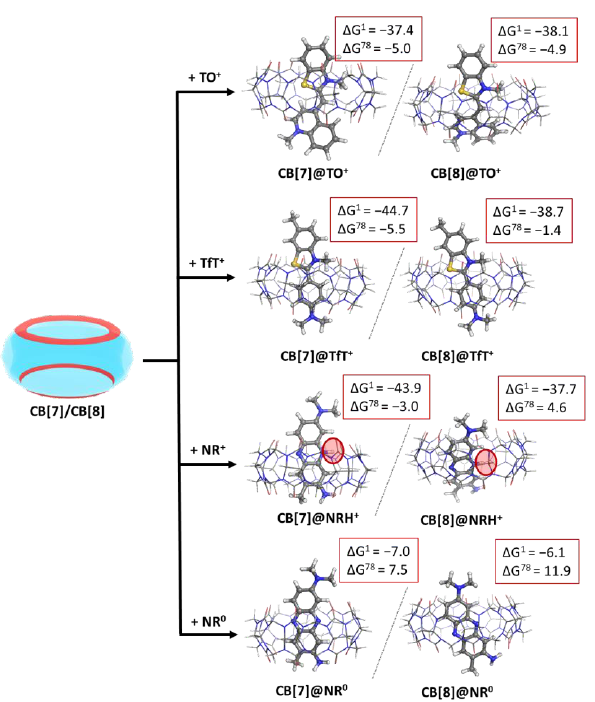
Figure 2. M062X/6 −3 1G(d,p) optimized structures of the CB[7/8]@dye complexes in the gas phase and the corresponding ∆G ε values in kcal mol −1 for their formation in the gas phase ( ε = 1), and water ( ε = 78) at the M062X/6 −3 1+G(d,p)//M062X/6 −3 1G(d,p) level of